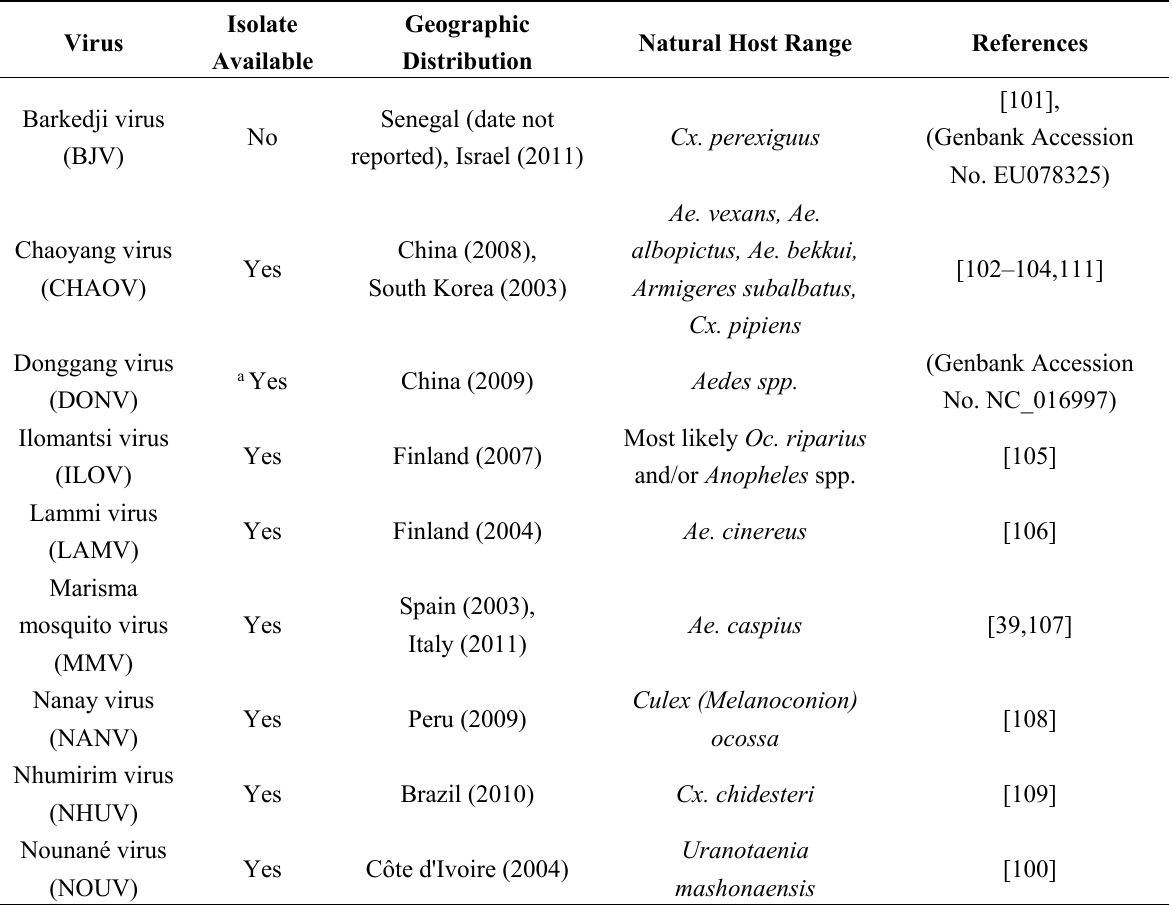
Table 4. Geographic distribution and natural host range of dual-host affiliated insect-specific flaviviruses.